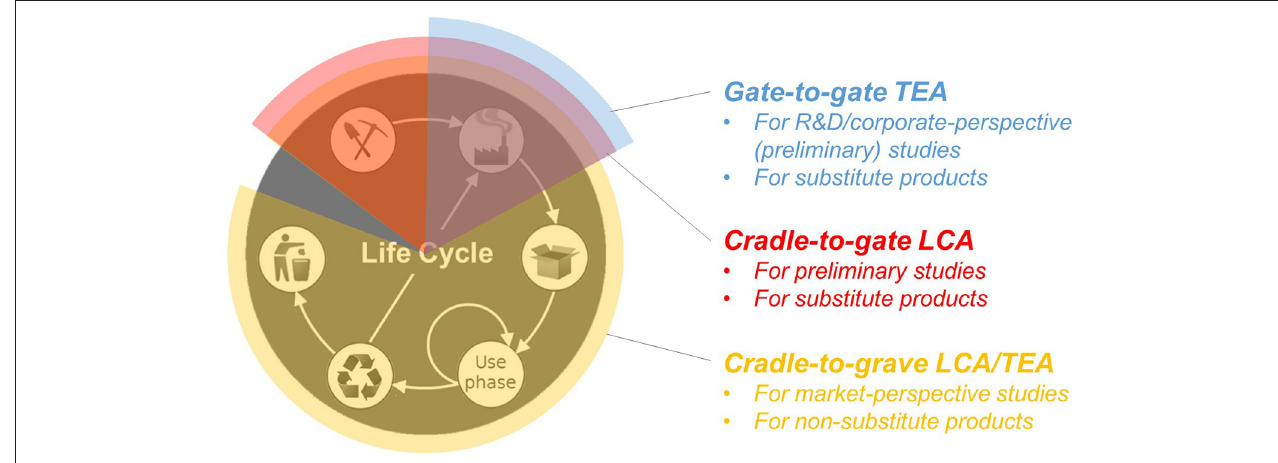
FIGURE 4 | The scope of TEA and LCA in the product life cycle, adapted from von der Assen